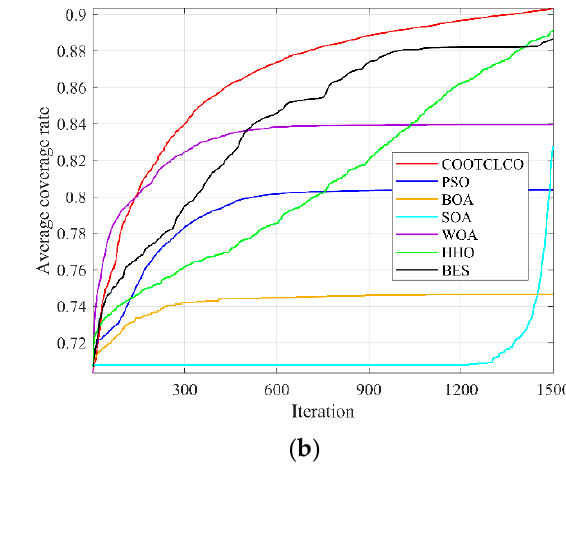
( c ) Figure 13. Comparison of the average coverage rate curves of the seven algorithms in the three cases: ( a ) q = 25, Rs = 10 m, Iteration = 1500; ( b ) q = 35, Rs = 10 m, Iteration = 1500; ( c ) q = 45, Rs = 10 m, Iteration = 1500.